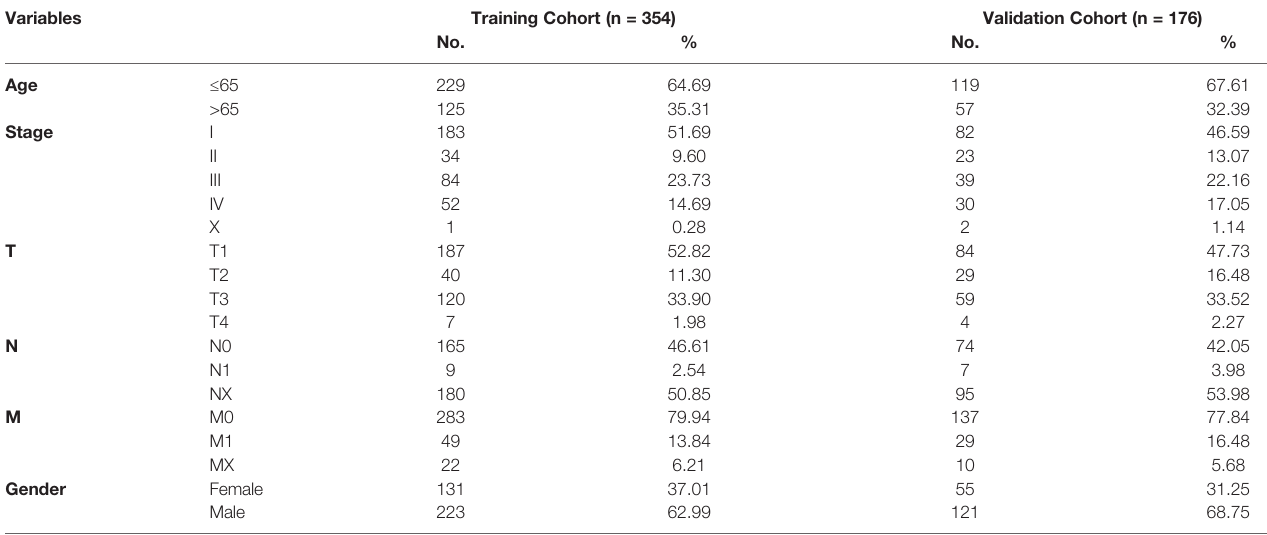
To obtain suitable FI-DEGs as biomarkers, we fi rstly performed the univariate Cox regression analyses for those 138 FI-DEGs correlated with DMPs and found 61 FI-DEGs were correlated with the overall survival (OS) of patients with KIRC in